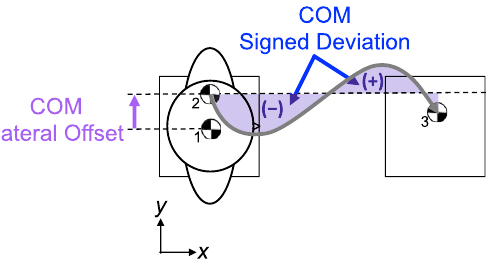
Figure 3. Center of Mass Data Analysis COM lateral offset, shown in purple, was defined as the lateral distance between the COM location before the “GO” cue (1) and COM location at first toe-off (2). This value represents lateral excursion of the COM prior to forward movement. The grey trajectory represents the COM motion during the trial. COM signed deviation was defined as the blue shaded area between the grey trajectory and a straight-line path originating from (2) and ending at (3). Deviations to the right of the straight-line path were given negative values, and deviations to the left were positive. Positive and negative deviations were added together for the total signed